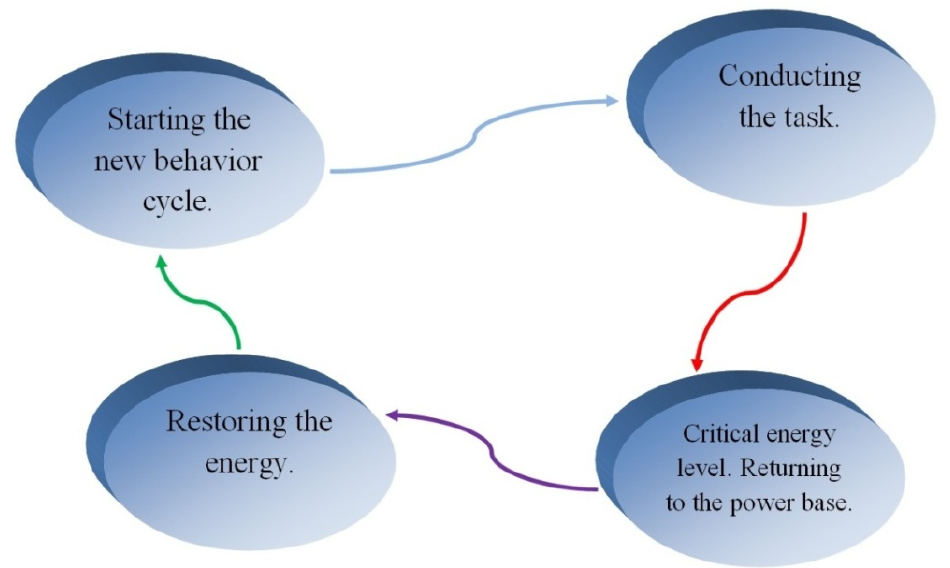
Figure 4. A simplified graphical representation of the general behavior cycle that is applied to agents.